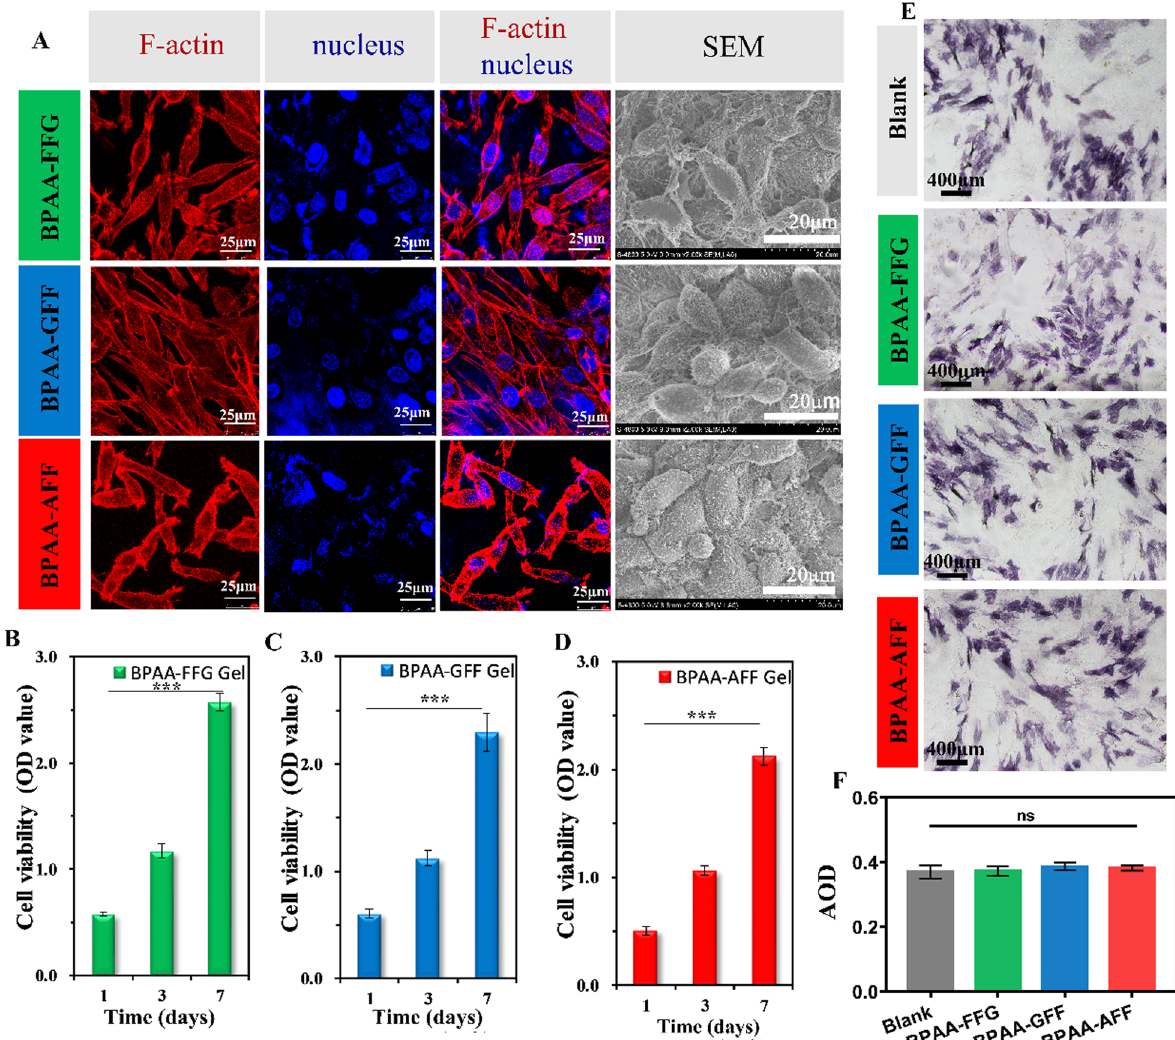
Fig. 6 A CLSM images (Rhodamine-phalloidin/Hoechst staining) and SEM images of L929 cells encapsulated into Gel-FFG, Gel-GFF and Gel-AFF. B – D The proliferation of L929 cells encapsulated into Gel-FFG, Gel-GFF and Gel-AFF during 7 days incubation. E , F ALP staining images of BMSCs cultured in MEM and BPAA-tripeptides, and semiquantitative analysis by image J